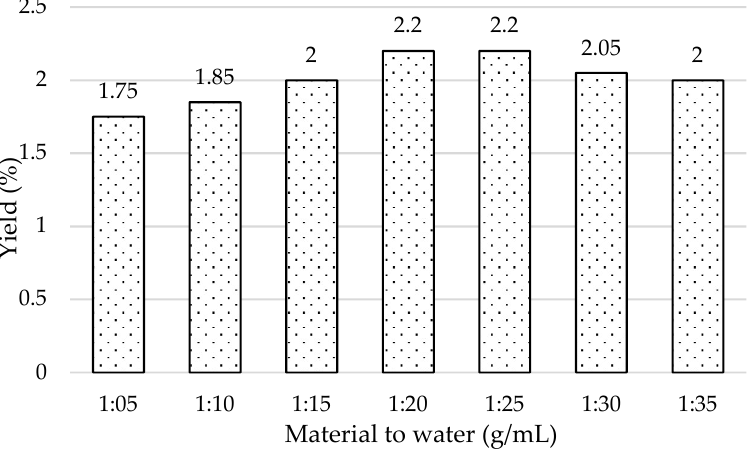
Figure 7. The influence of the material to water ratio on the yield of essential oil.